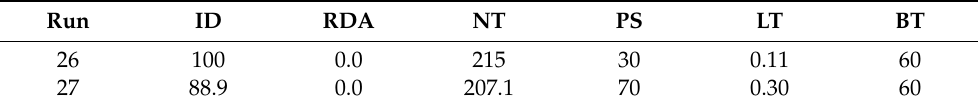
Table 8. Control parameters for the confirmation runs.